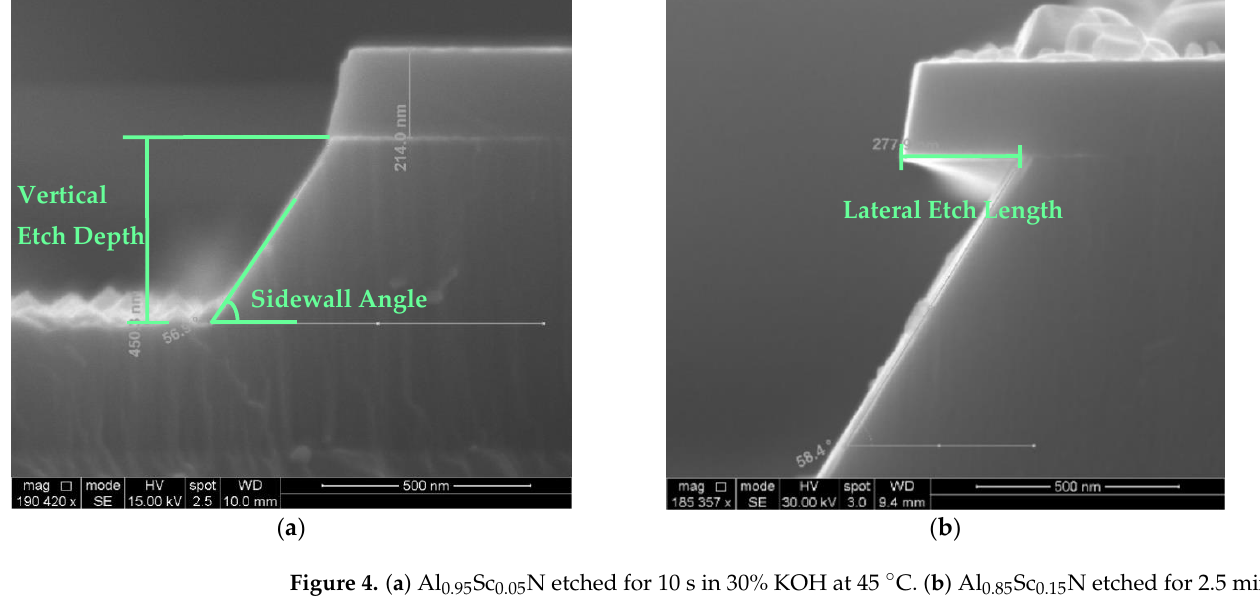
Figure 4. ( a ) Al 0.95 Sc 0.05 N etched for 10 s in 30% KOH at 45 °C. ( b ) Al 0.85 Sc 0.15 N etched for 2.5 min in 30% KOH at 65 °C.